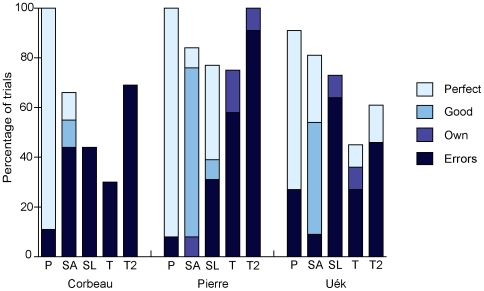
Success rates of crows in Experiment 2.Bar shading indicates the type of success: when ‘Errors’ were made, food was retrieved but the sequence of behaviour contained errors; ‘Own’ refers to a small number of trials where subjects used their own method of obtaining food (see text and Video S2); ‘Good’ refers to trials where the food was out of reach of the tabletop tool and subjects still directed their first probes into the food-frame, but all subsequent actions were correct; ‘Perfect’ means no errors were made in the acquisition of food. Trial types are coded as follows: P = Primary; SA = Secondary-Any; SL = Secondary-Long; T = Tertiary; T2 = Tertiary-2.